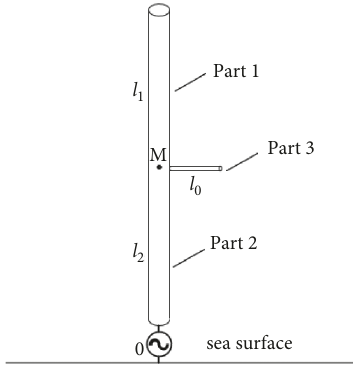
Figure 1: Schematic diagram of the middle loading whip